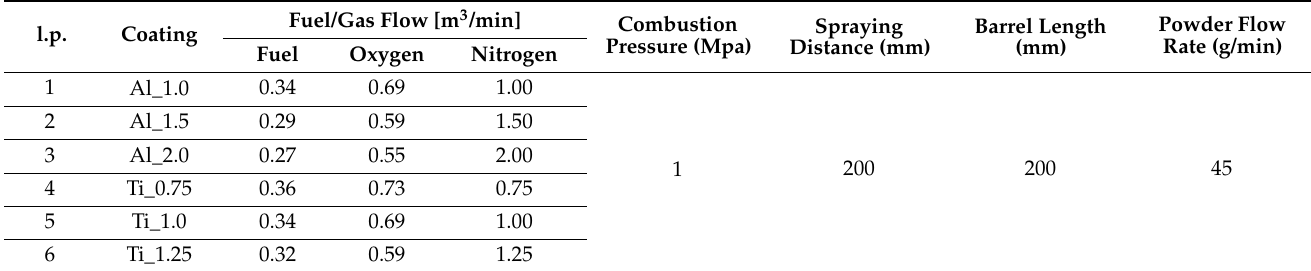
Figure 3. Schematic of the WS gun [29]. Reproduced with permission from Kuroda, S. et al., Journal of Thermal Spray Technology; published by Springer Nature, 2011. Table 1. WS